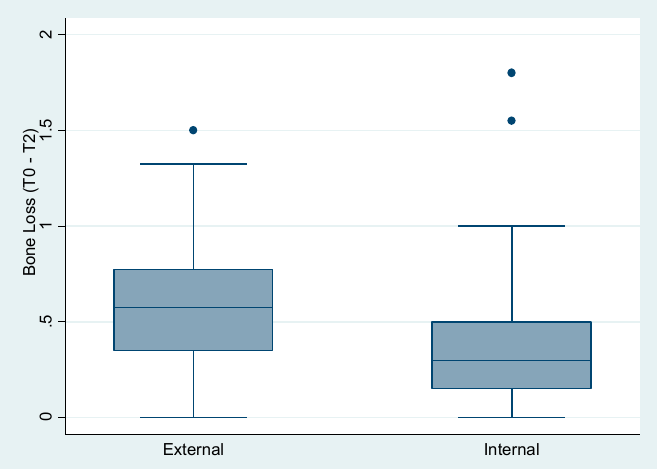
Figure 5. Bone loss (mm) in internal vs. external connection implants between the second and third measurements ( T 1– T 2).